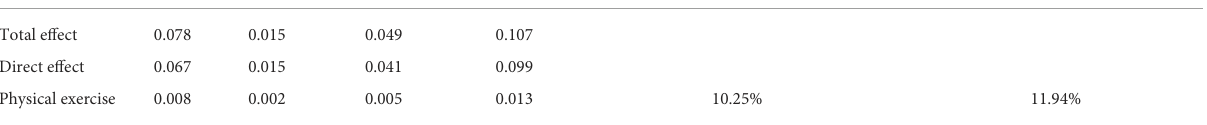
TABLE 5 Results of the mediating